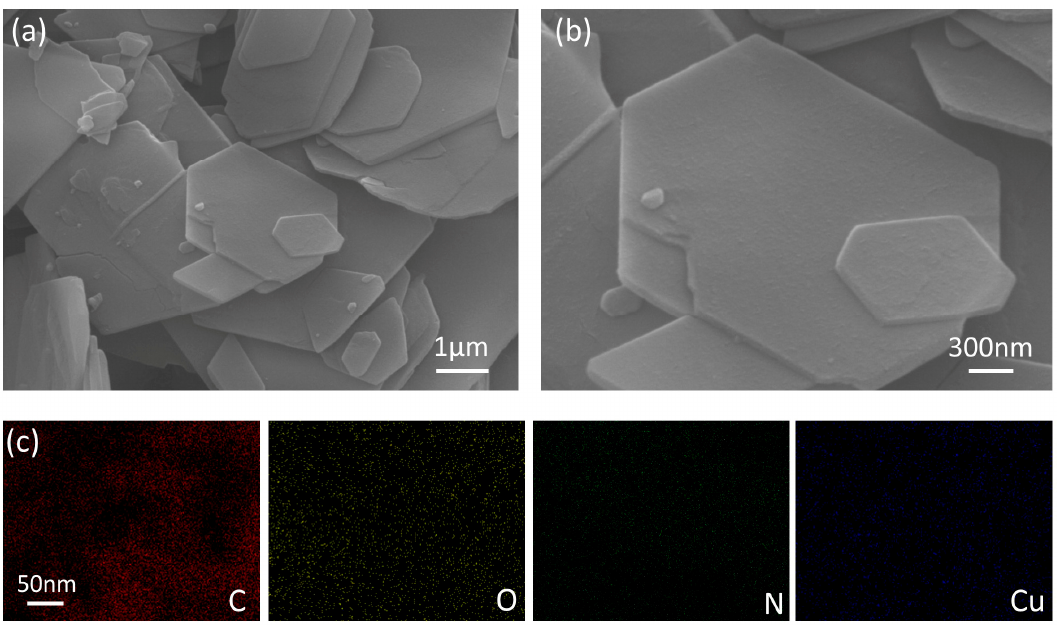
Figure 3. Morphology analysis. ( a , b ) SEM images and ( c ) elemental mapping analysis of Cu(II)–[4ABA–MA].